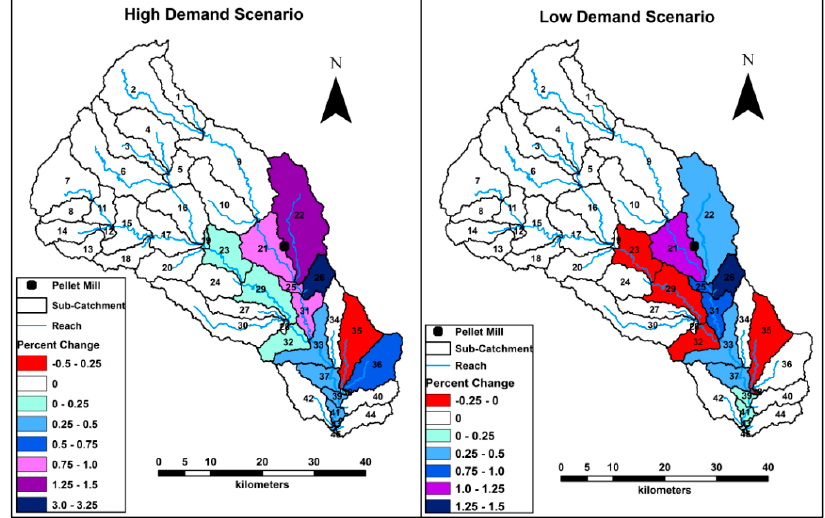
Figure 10. Change in streamflow under the High and Low Demand scenarios for industrial wood pellets at the sub-watershed level. Actuators 2018 , 7 , x FOR PEER REVIEW